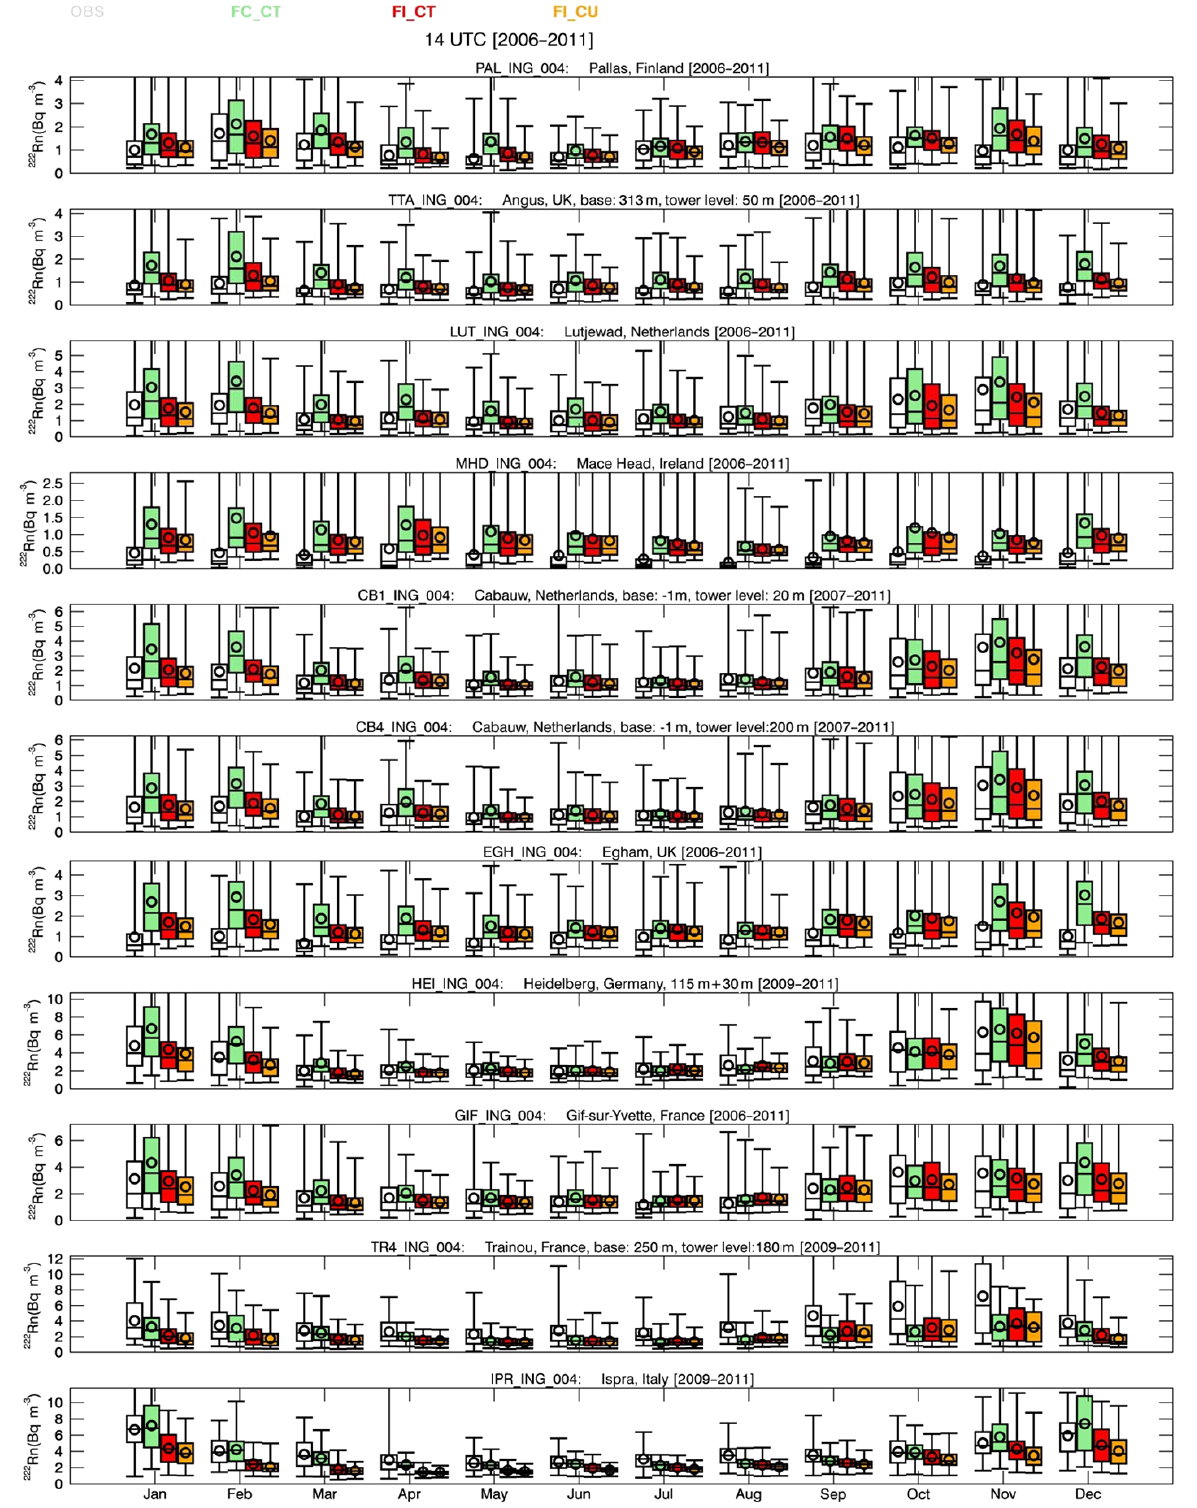
Figure 7. As in Fig. 6, but at 14:00UTC illustrating the seasonal variations of daily minimum of radon ( 222 Rn) activity concentrations.